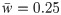
Thrombus shapes in a vessel under different flow conditions.The geometric parameters for thrombus shape are hs = 0.5 and hc = 0.3. Phase-field profile at different blood velocity: (a) w¯=0.25, (b) w¯=1.0, (c) w¯=1.6 shown at time T = 0.91. Phase-field plots shown on xz−plane at y = 0 in the first row and on xy−plane in the second row. w¯: Average velocity in z-direction. ϕ = 1 denotes flowing blood and ϕ = 0 denotes solid thrombus.